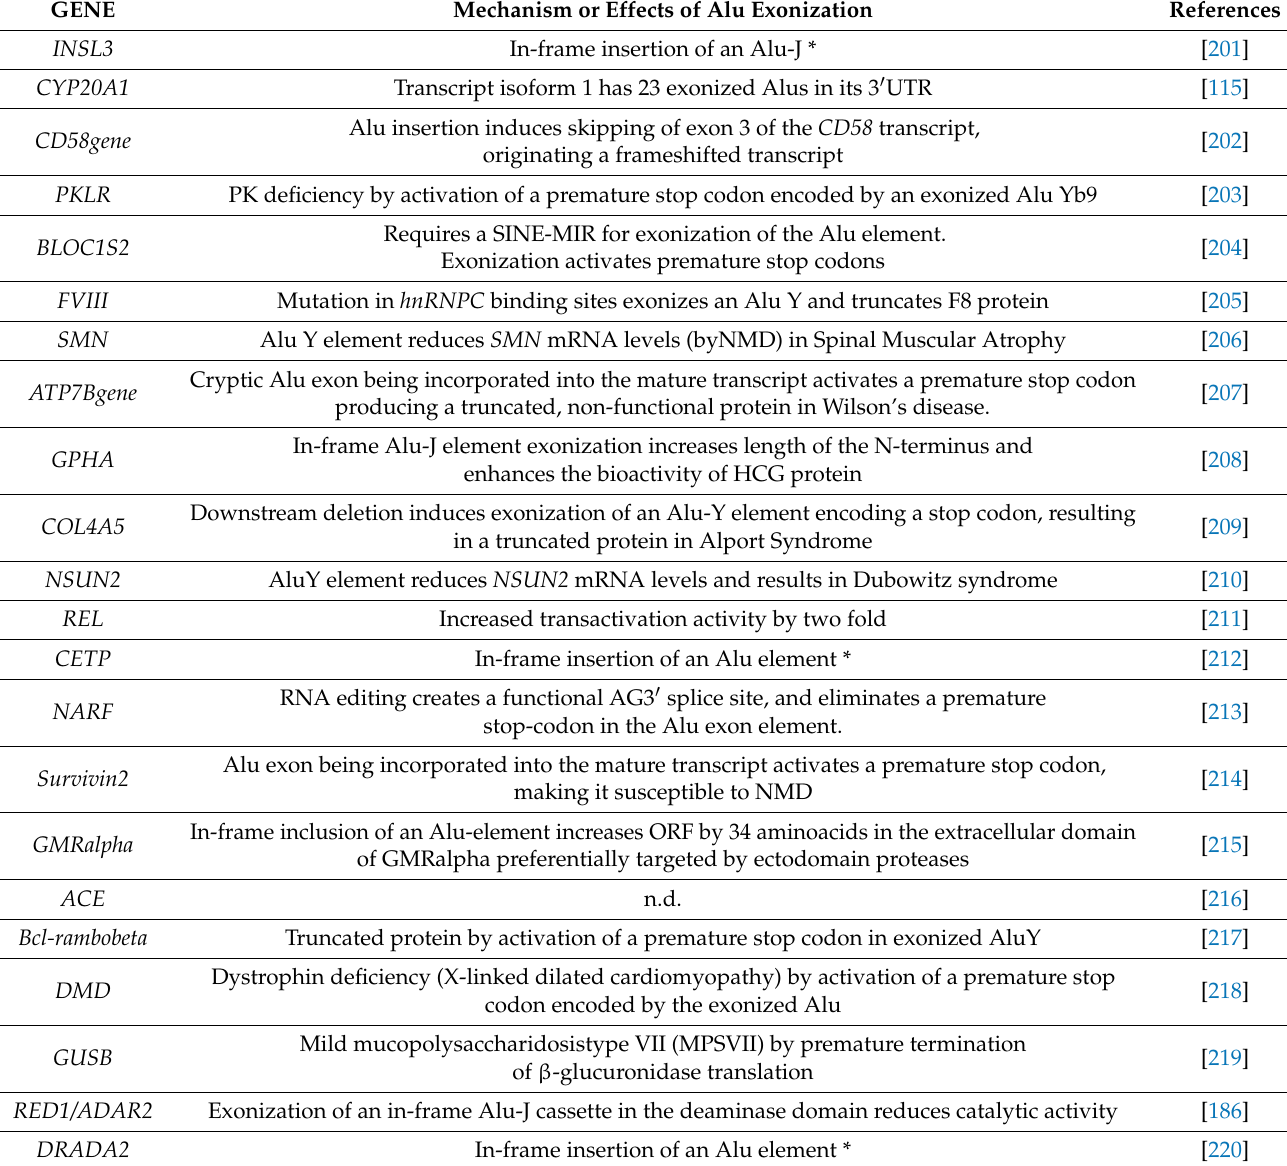
Table 2. Alu repeat-mediated exonization events causing gene alterations or human disorders. Shown are the transcript affected, the mechanism and effects of Alu exonization and the reference of the work. GENE Mechanism or Effects of Alu